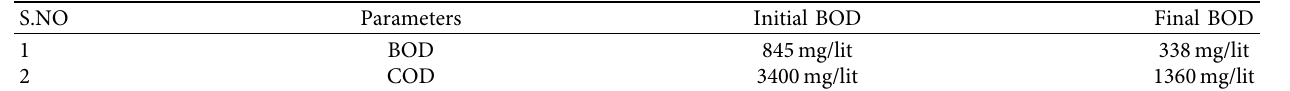
Table 5: Characteristic of BOD and COD.